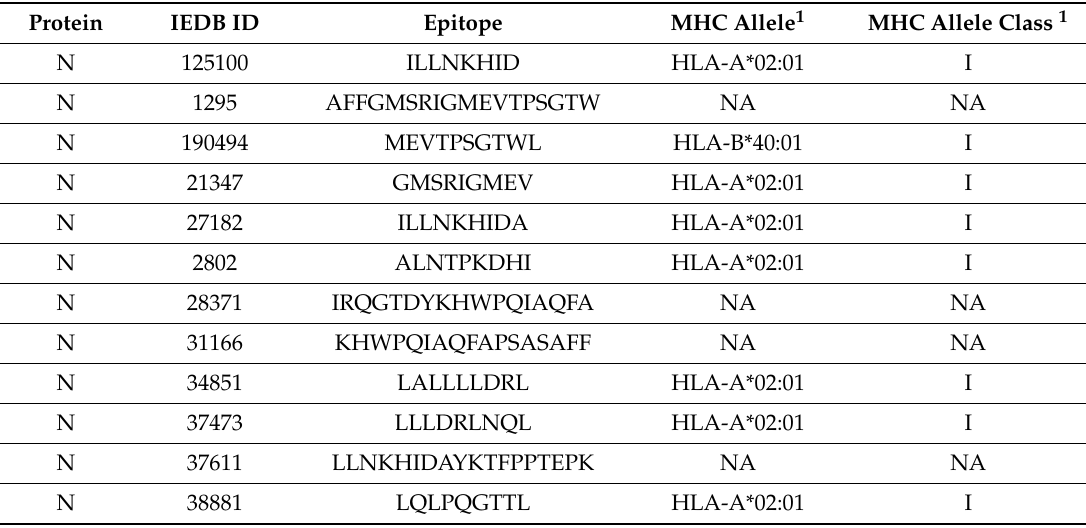
Table 2. SARS-CoV-derived T cell epitopes obtained using positive T cell assays that are identical in SARS-CoV-2 (27 epitopes in